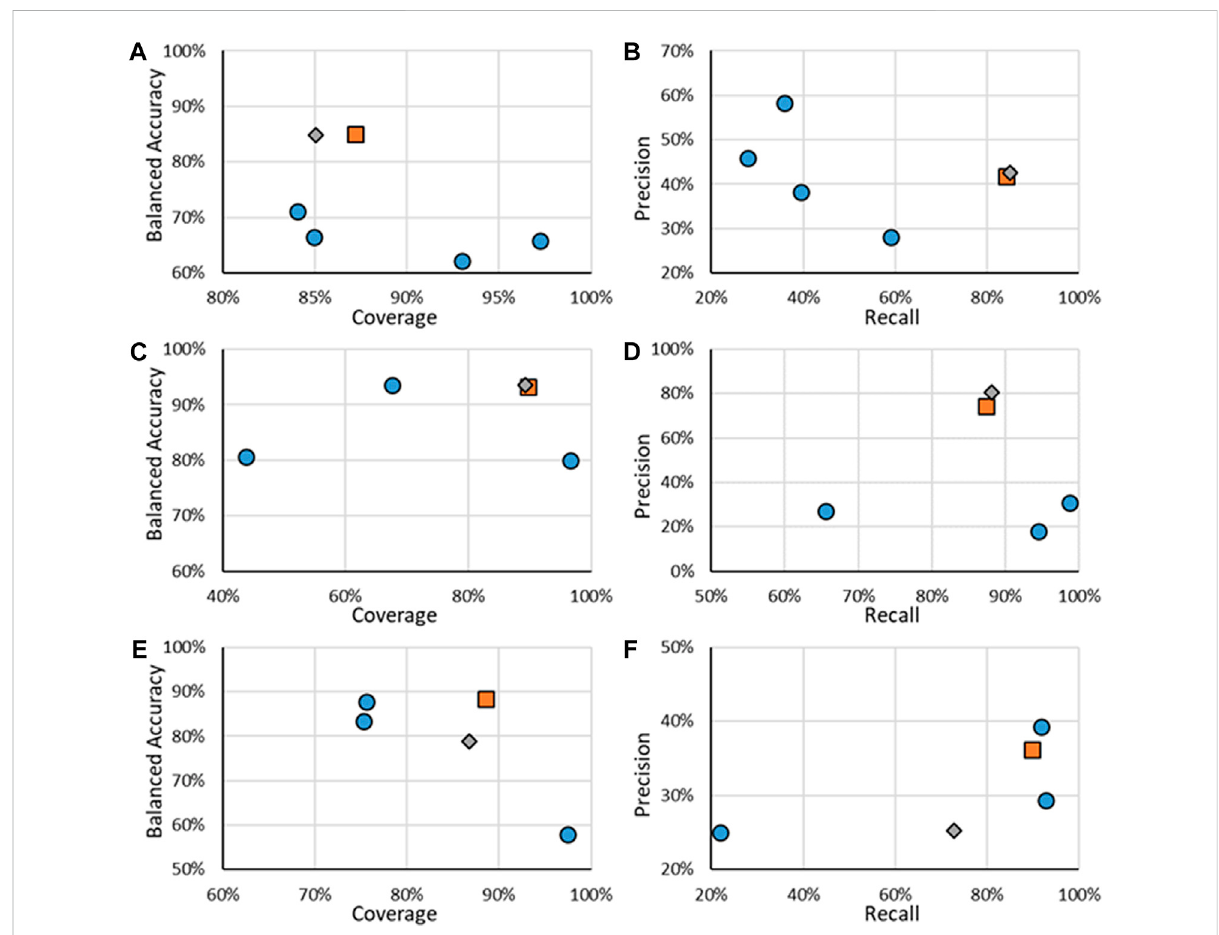
FIGURE 5 Statisticsof performance of the binary ER activity models for binding (A,B) , agonism (C,D) , and antagonism (E,F) . A, C, and E show the results of BA as a function of Coverage while B, D, and E show Precision as a function of Recall. Orange squares are for RF models when all substances are considered, gray diamonds are when only the substances in the RF test substances are considered, and blue circles are for other